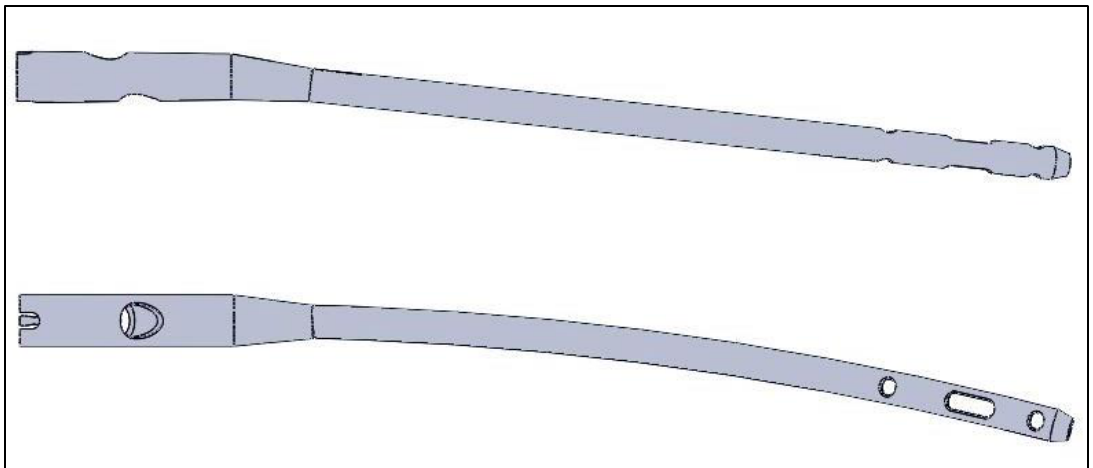
Figure 1. Generated model for the femoral nail. Reprinted from Ref. [21].